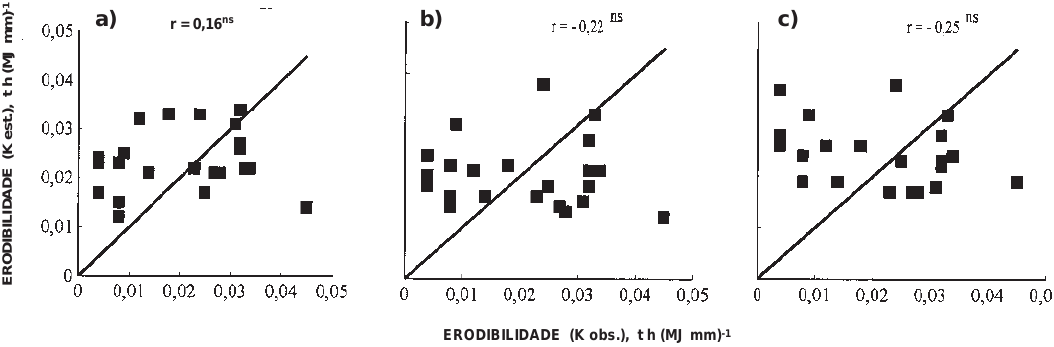
Figura 3. Relação entre o K estimado (K est.) pelos métodos 5 (a), 6 (b), 7 (c) e o K observado (K obs.). O traço contínuo representa a linha 1:1 (ns = não significativo).